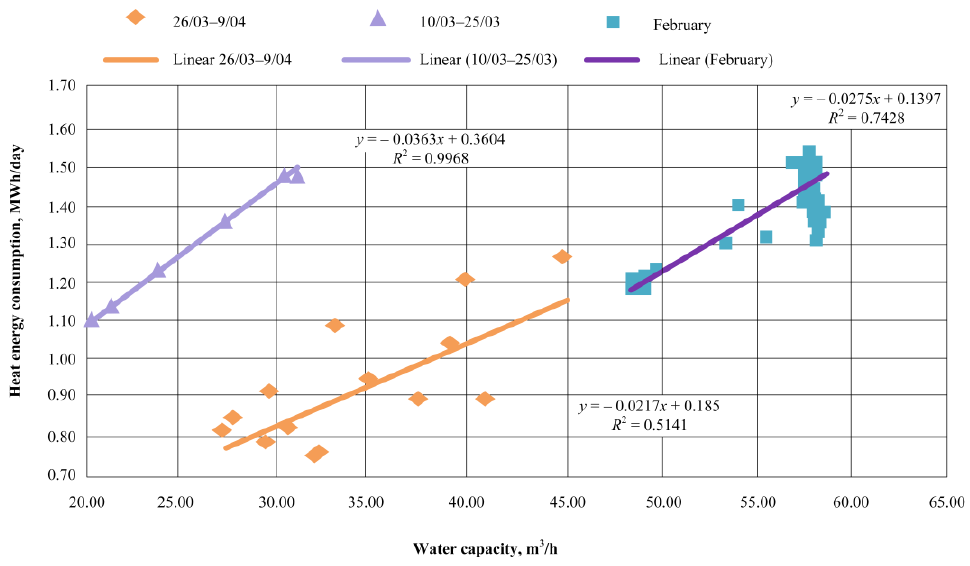
Fig. 6. Heat consumption depending on water temperature difference.